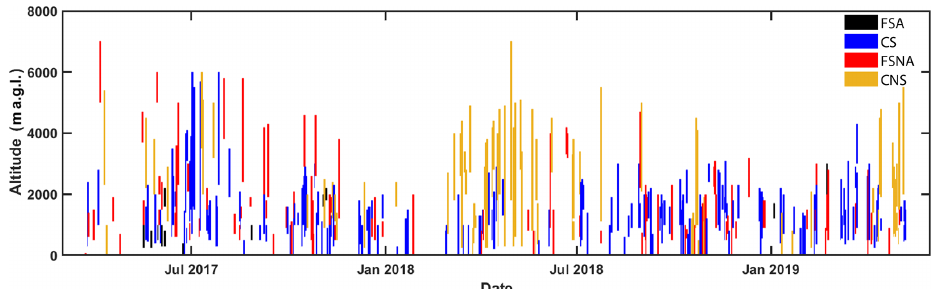
Figure 7. Overview of the altitude and extent of the analyzed aerosol layers above Haifa, Israel, between March 2017 and May 2019. Each layer is colored by its dominant aerosol component: black, blue, red, and yellow bars correspond to fine spherical, absorbing (FSA); coarse, spherical (CS); fine, spherical, non-absorbing (FSNA); and coarse, non-spherical (CNS),